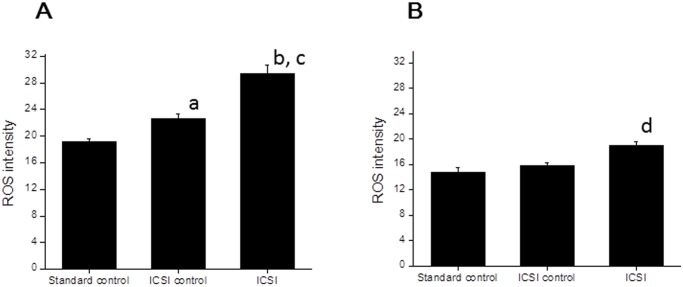
Effect of mock injection on Reactive oxygen species level in in vivo and in vitro matured murine oocytes assessed using 2′,7′-dichlorodihydrofluorescein diacetate (DCHFDA) staining.A. Oocytes retrieved from superovulated mice, subjected to mock ICSI were assessed for ROS production. The relative ROS intensity in standard control (N = 19), ICSI control (N = 22) and ICSI group (N = 20), was determined. The error bars represent the corresponding SEM (Mean ± SEM). aP <0.05: Standard control Vs ICSI control, bP <0.01: Standard control Vs ICSI group, cP < 0.001: ICSI control Vs ICSI group. B. In vitro matured metaphase II oocytes, subjected to mock ICSI were assessed for ROS production. The relative ROS intensity in standard control (N = 28), ICSI control (N = 25) and ICSI group (N = 26), was determined (Mean ± SEM). dP < 0.001: Standard control Vs ICSI group and ICSI control Vs ICSI group.